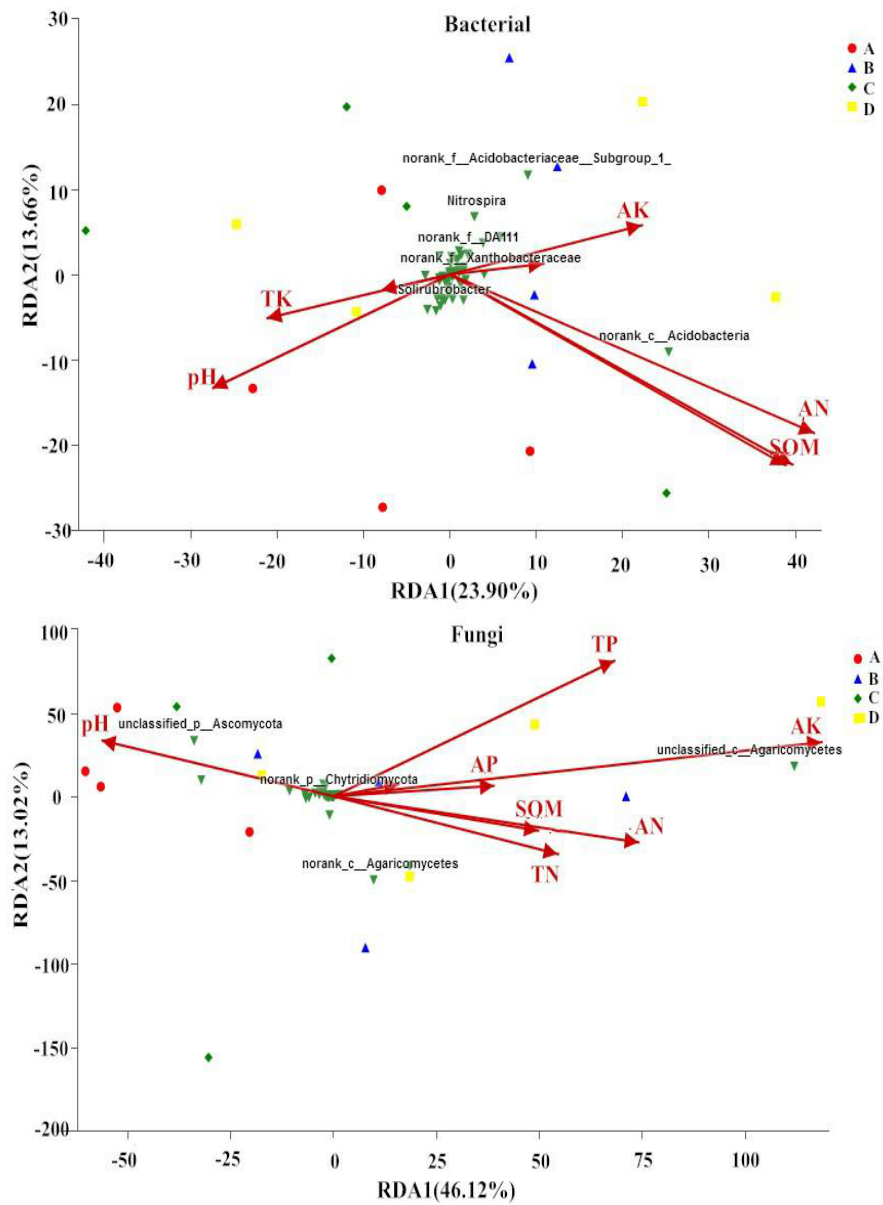
Figure 4. Redundancy analysis (RDA) of the relationships between soil physiochemical properties and bacterial and fungi communities under different forest management methods. A indicates close-to-nature forest management (CNFM), B indicates structure-based forest management (SBFM), C indicates unmanaged control (CK), and D indicate secondary forest comprehensive silviculture (SFCS). Table 4. Correlation analysis between RDA and soil properties with soil microbial at the genus level.